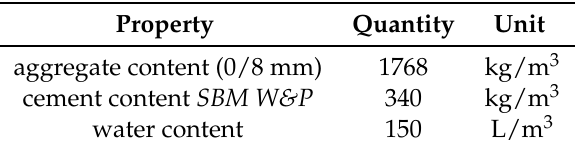
Table 2. Composition of shotcrete for the tests presented by Müller